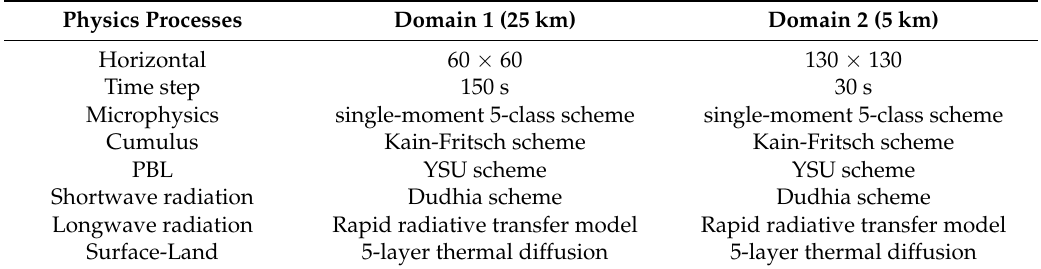
Table 1. Physical configuration of the WRF model used in this